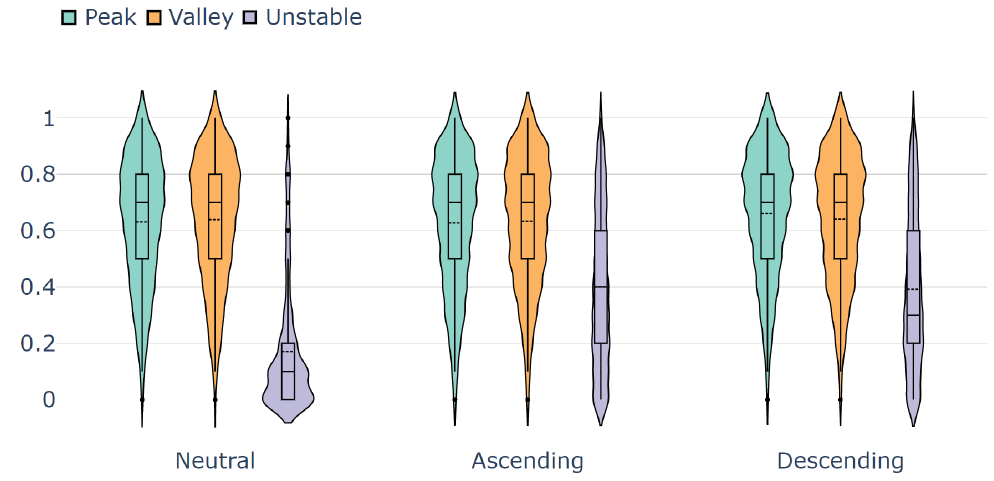
Figure 9. Query stability analysis. On average, slight variations in the selection return 39% to 64% of the documents returned by the original query depending on the pattern type, indicating a good degree of stability and reproducibility, especially for patterns with peaks and